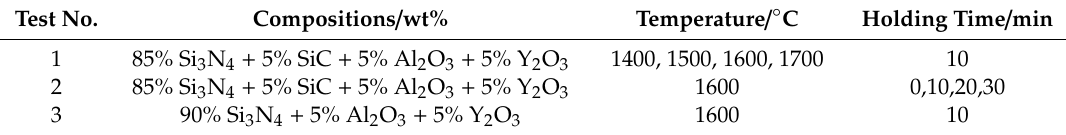
Figure 1. Heat preservation device (1—Mullite box, 2—Aluminium silicate, 3—Polycrystalline mullite fiber cotton, 4—Crucible, 5—Silicon carbide powder, 6—Hole for infrared temperature, and 7—Specimen). Table 1. The sintering temperature and holding time of the series ceramic materials.